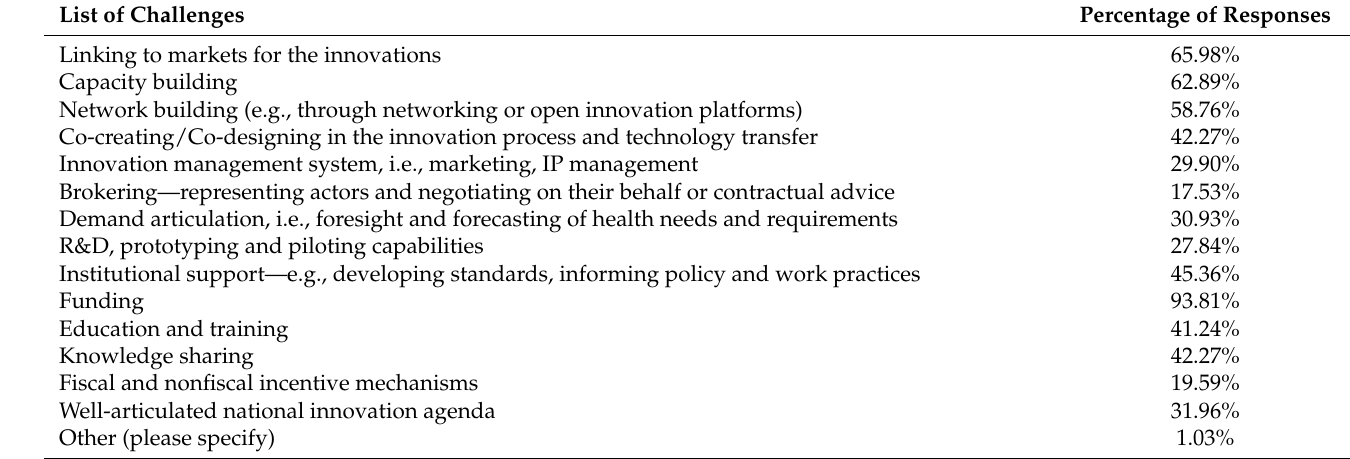
Table 2. Innovator-identified ecosystem